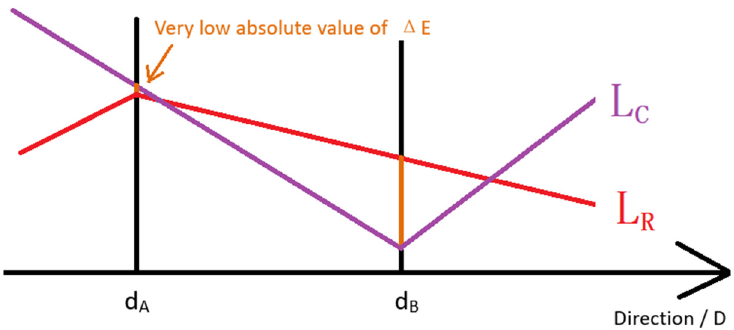
Figure 7. The case to trigger the original error avoiding mechanism within